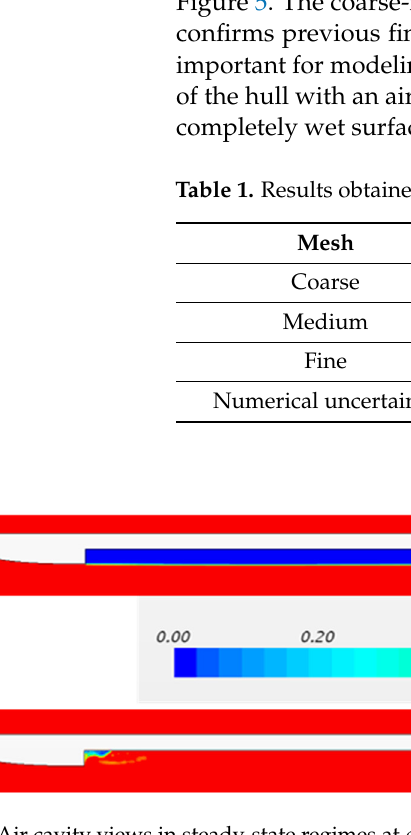
Figure 5. Air cavity views in steady-state regimes at 𝑞 = 0.016 and 𝑈 = 5.4 m/s obtained on ( a ) fine mesh and ( b ) coarse mesh. Table 1. Results obtained in mesh-dependency study at 𝑞 = 0.016 and 𝑈 = 5.4 m/s.